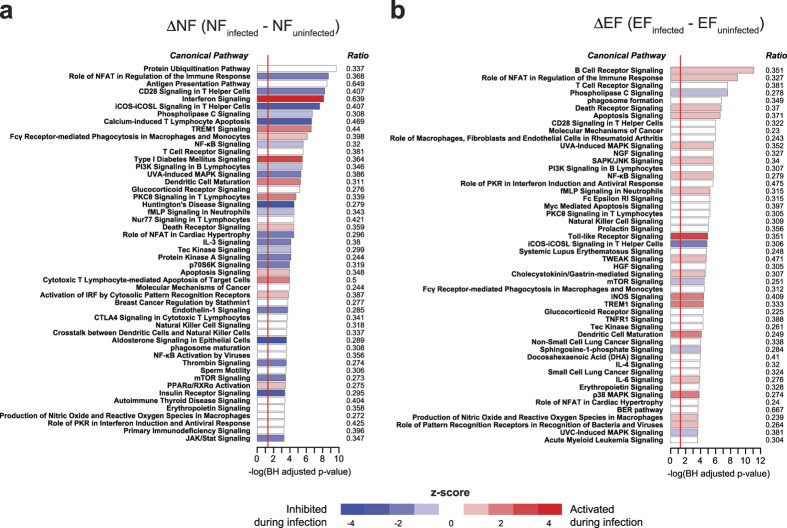
Molecular signatures of febrile malaria in naïve and malaria-experienced individuals differ in intensity and quality by pathways analysis.Canonical pathways analysis using DEGs with FDR <0.05 (no fold-change cut-off) for the ΔNF (a) and ΔEF (b) classes.